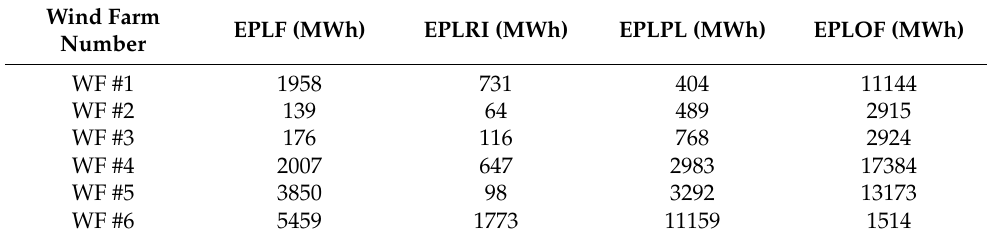
Table 7. The calculation results of energy production loss of wind farms. Wind Farm